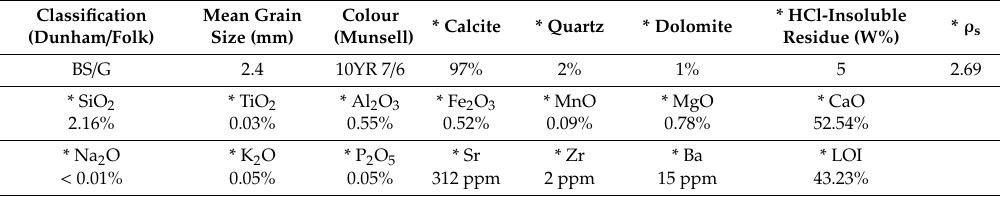
Table 2. List of petrographic, mineralogical, and physical characteristics of Pietra d’Aspra samples. Classification (Dunham / Classification